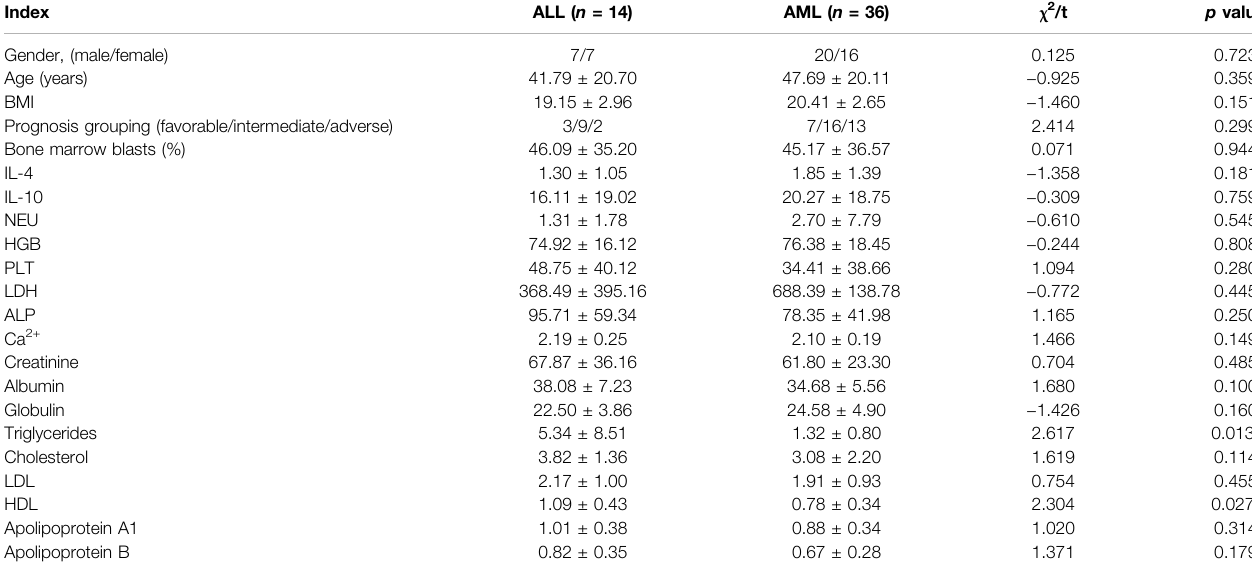
TABLE 1 | Comparison of demographics, prognosis grouping, cytokines and clinical details between AML and ALL patients (Means ± SD). Index Gender, (male/female)